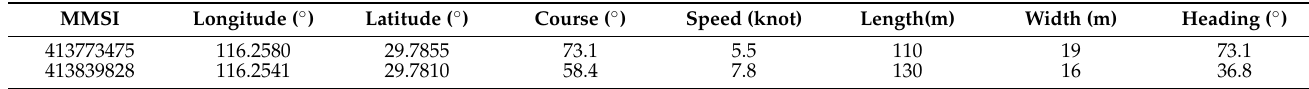
Table 6. AIS data of Case 3.